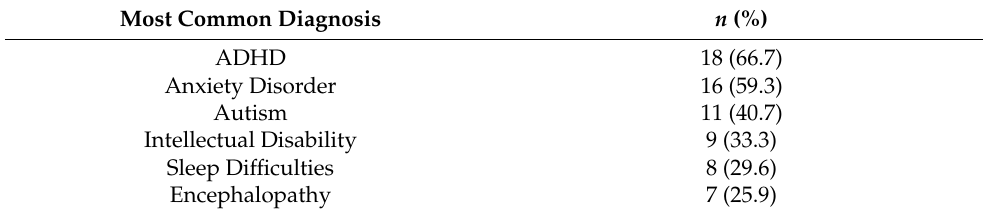
Table 5. Most common diagnosis for